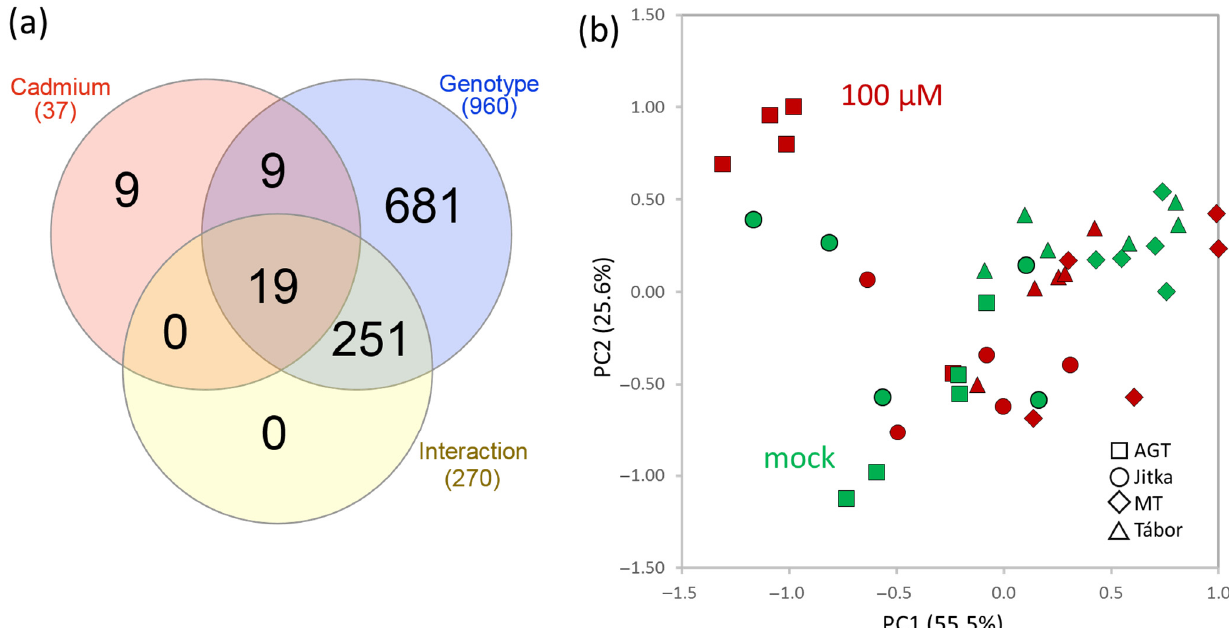
Figure 2. The proteome profile of the flax suspension cultures did not show the expected separation of the mock and cadmium treated cells. ( a ) Results of two-way ANOVA analysis visualized in a Venn diagram and ( b ) PCA based on profile of all 969 differentially abundant proteins. For details, see Supplementary Tables S1 and S2.